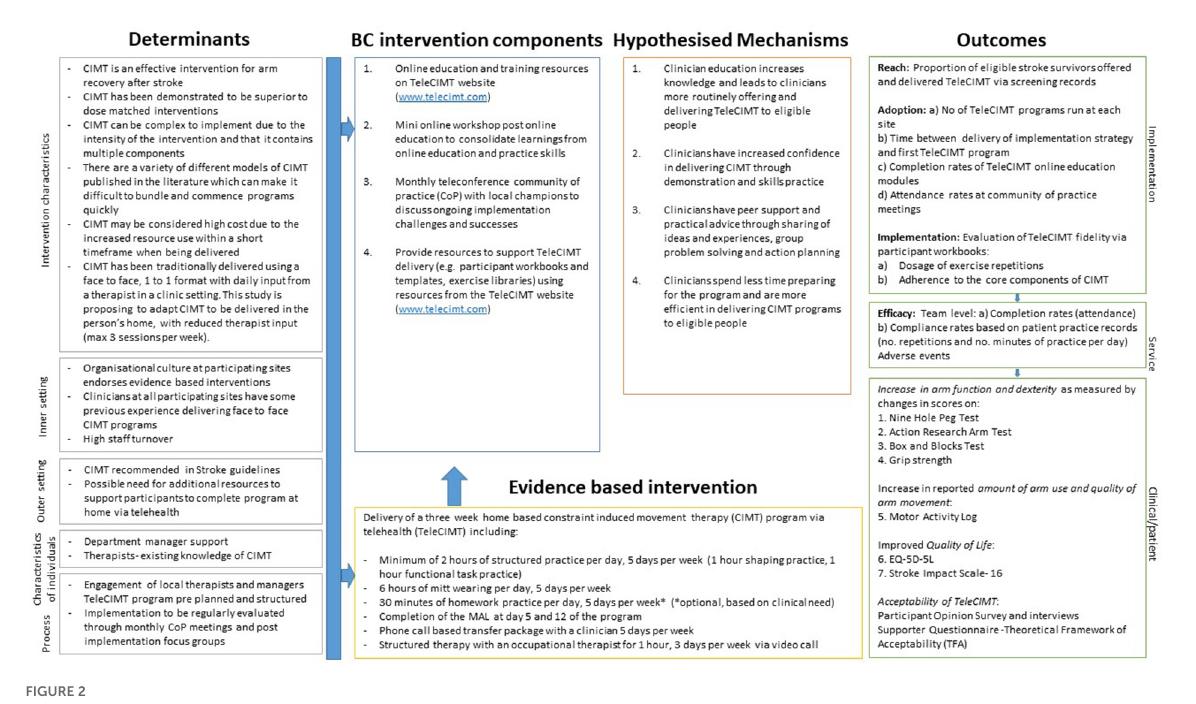
FIGURE2 Implementation research logic model for ReCITE study